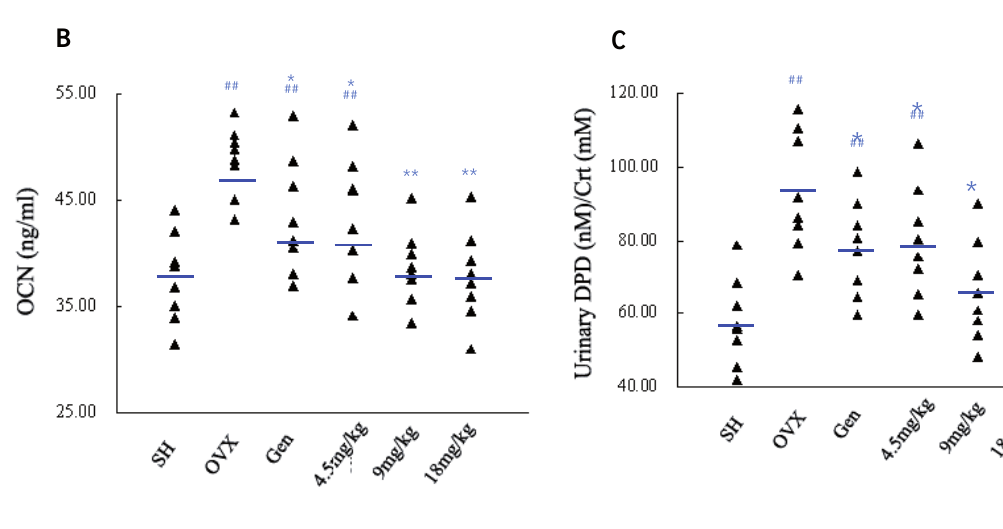
Serum biomarkers of bone turnover. (A) serum b-ALP; (B) serum osteocalcin (OCN); (C) Urinary DPD. Serum markers were determined by commercially available kits as specified by the manufacturers. OVX increases serum b-ALP and OCN levels. After drugs donation, these effects have all been reversed. Compared with OVX group, Gen and NO-G (4.5 mg/kg) reduced b-ALP by 7.36% and 7.83%, OCN by 17.3% and 16.1%, NO-G (9 and 18 mg/kg) reduced b-ALP by 14.5% and 15.0%, OCN by 33.3% and 35.2% respectively. Urinary DPD level (expressed as nM of DPD per mM of crea- tinine to correct urine volume) in OVX rats. OVX significantly increases urinary DPD level. Administration of 9 or 18 mg/kg NO-G to OVX animals significantly reduced DPD levels to 70.8% and 74.6% of OVX (P <0.01) and has no difference with SH group. The effect of genistein was not that significant (83.8% of OVX group, P <0.05), while 4.5 mg/kg NO-G seems has no effect on DPD. Data are expressed as the Means with SEM of 8 rats. *p <0.05, **p <0.01 vs OVX; ##p <0.01 vs SH. (SH: Sham-operated; OVX: OVX control; Gen: